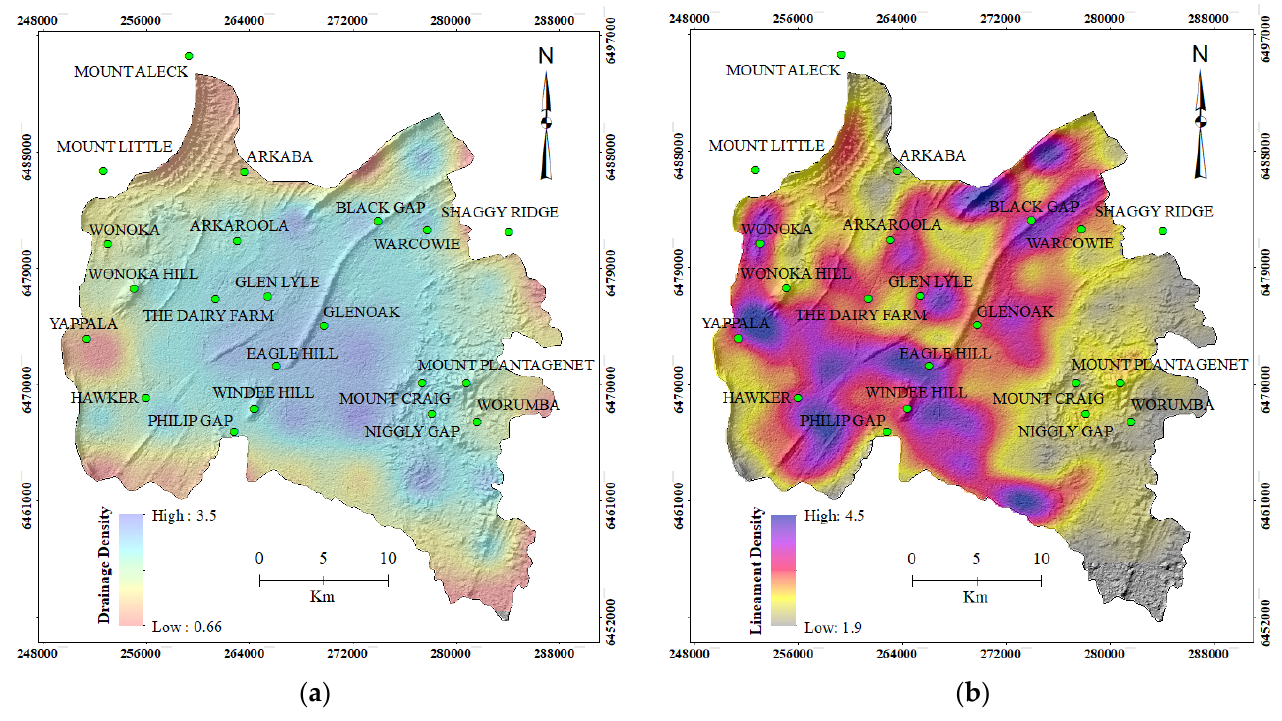
Figure 6. ( a ) Drainage Density and ( b ) Lineament density.